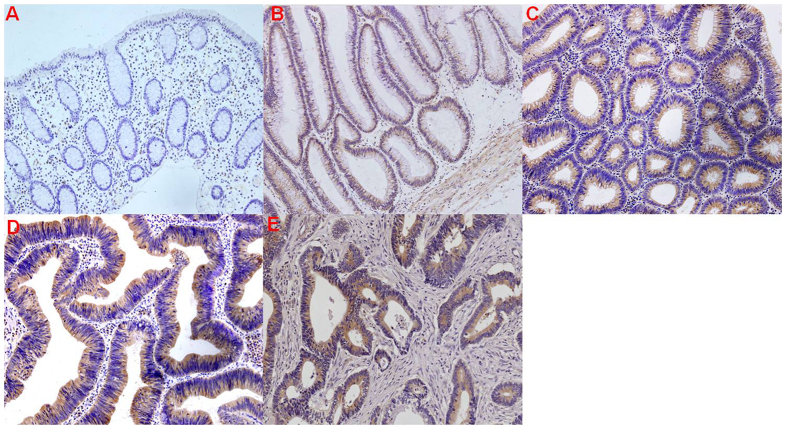
Immunohistochemistry results of LCN-2 expression in the different clinical groups.(A) Absence of staining for LCN-2 in the normal colorectal mucosa. LCN-2 immunohistochemical expression was evident in the cytoplasm of the neoplastic cells of LSTs and TNM stage I colorectal carcinomas, and was further increased in LSTs with LST progression. (B) Weak LCN-2 staining in low-grade intraepithelial LSTs neoplasia. (C) Moderate LCN-2 staining in moderate intraepithelial LSTs neoplasia. (D) Marked LCN-2 staining in high-grade intraepithelial LSTs neoplasia. (E) Moderate LCN-2 staining in TNM stage I colorectal carcinoma. (original magnification, 200×).